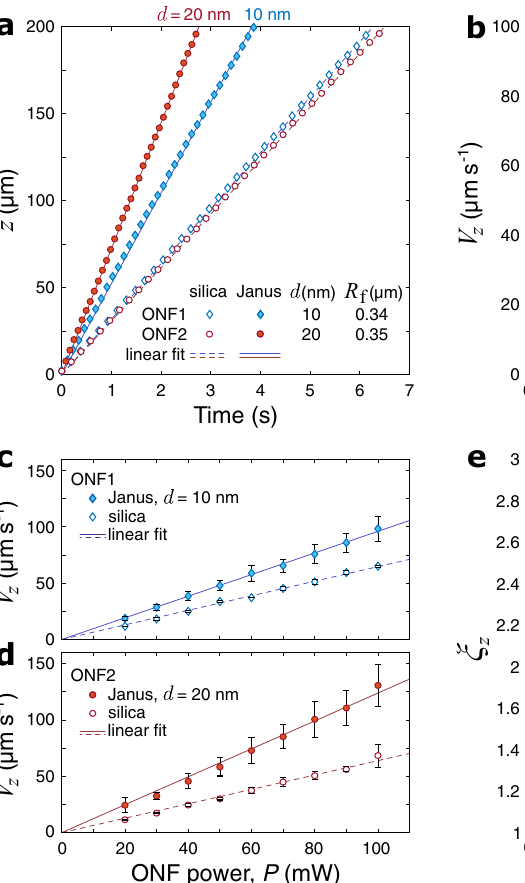
(no “ sail ” ) particles, except the “ sail ” gives a signi fi cant gain in the longitudinal speed.